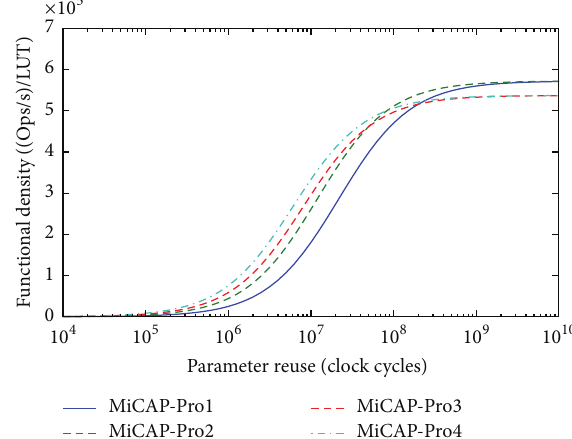
Figure 11: Functional density curves for MiCAP-Pro with different reconfiguration